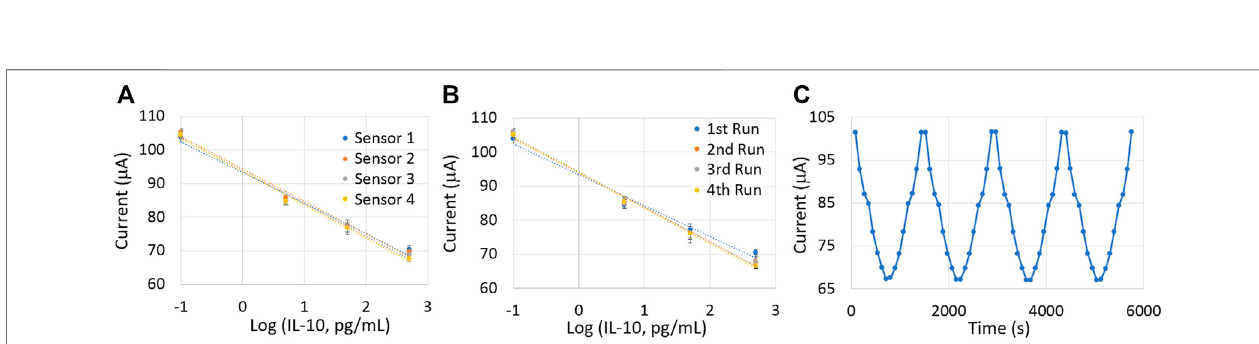
FIGURE 10 | (A) Sensor reproducibility test using four identical sensors. (B) Repeatability test conducted with the same sensor. (C) Reversibility test with cyclic variations in IL-10 concentrations. Measurements were repeated three times for each protein concentration.